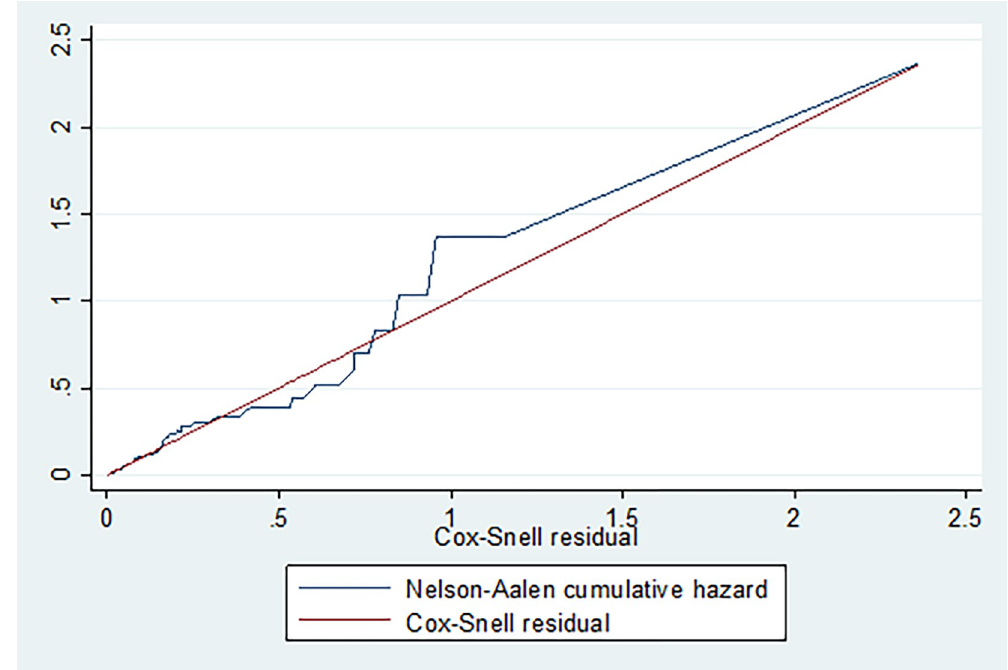
Fig 9. Cox-Snell residual to check proportional hazard model